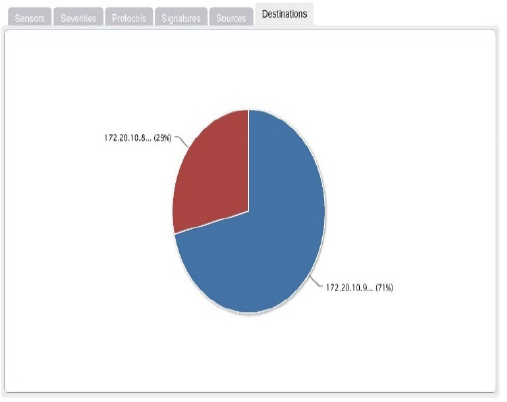
Fig. 23:Internal and external attack source information